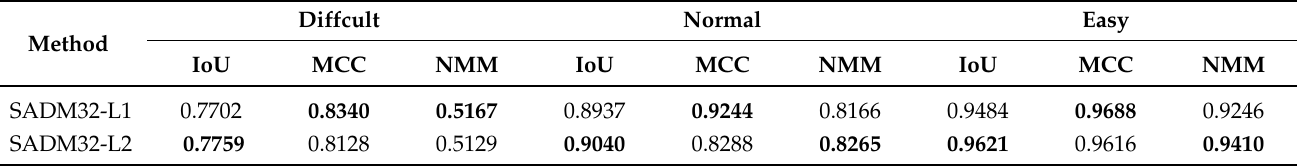
Table 2. The comparision of L1-Normalization an